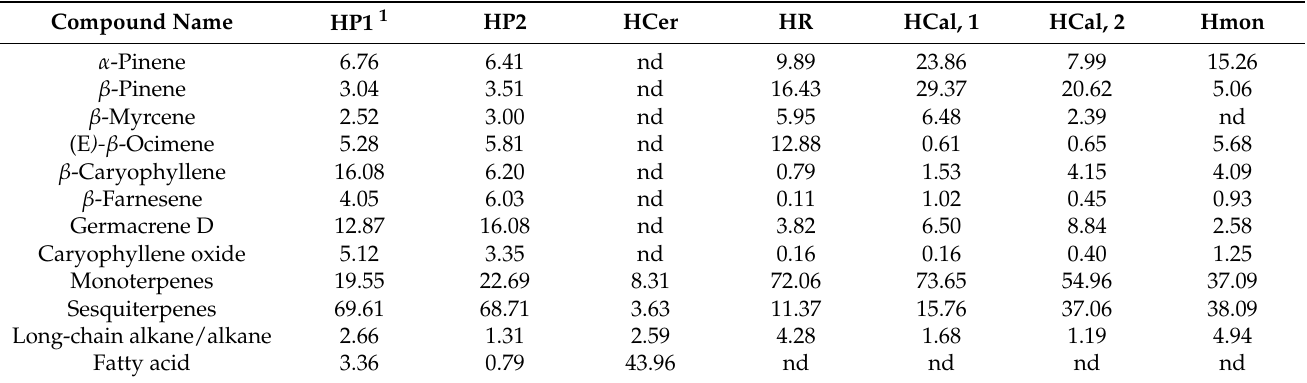
Table 4. Mean concentrations (%) of α -pinene, β -pinene, β -myrcene, ( E )- β -ocimene, β -caryophyllene, β -farnesene, germacrene D, caryophyllene oxide, monoterpenes, sesquiterpenes, long-chain alkane, and fatty acid of four Hypericum species extracted by n